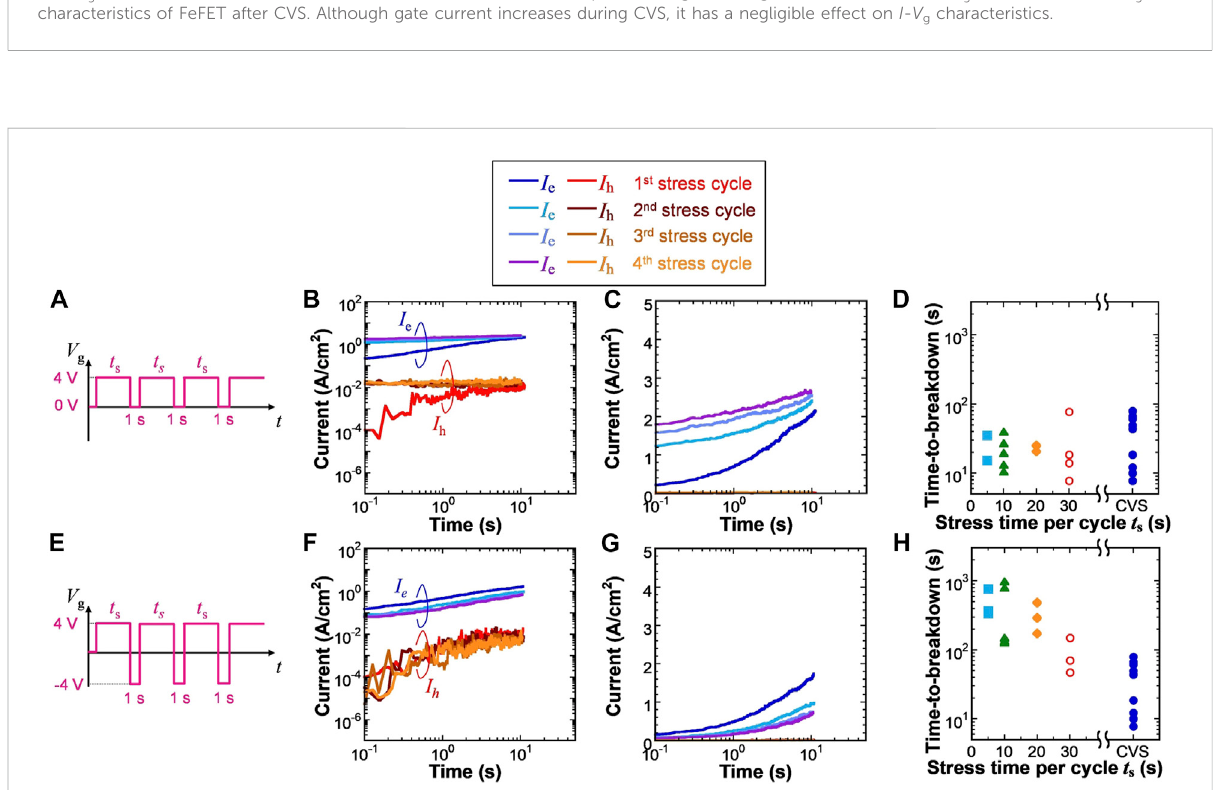
FIGURE 9 (B,C) Electronandholecomponentsofgateleakagecurrentat (A) Appliedvoltageschemewithrepeatingstressof4 Vfortime t s and0 Vfor1 s. each4-Vstresscyclefor t s =10 swhencurrentisplottedin (B) logscaleand (C) linearscale.Betweeneachstresscycle,testswereinterruptedby0 V for 1 s. (D) Total stress time (excluding 0 V interruption duration) before breakdown for different time t s of 4-V stress. (E) Applied voltage scheme when the interrupted voltage is − 4 V for 1 s. (F,G) Electron and hole components of gate leakage current at each 4-V stress cycle for t s = 10 s, whichwereinterruptedat-4 Vfor1 sbetweencycles,whencurrentisplottedin (F) logscaleand (G) linearscale. (H) Totalstresstime(excluding − 4 V interruption duration) before breakdown for different time t s of 4-V